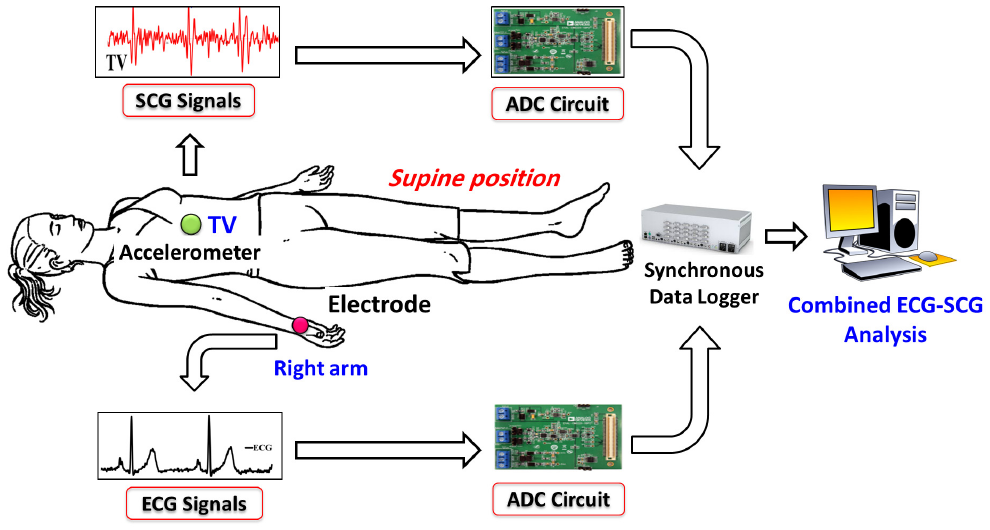
Figure 1. Architectural view of ECG/SCG data collection